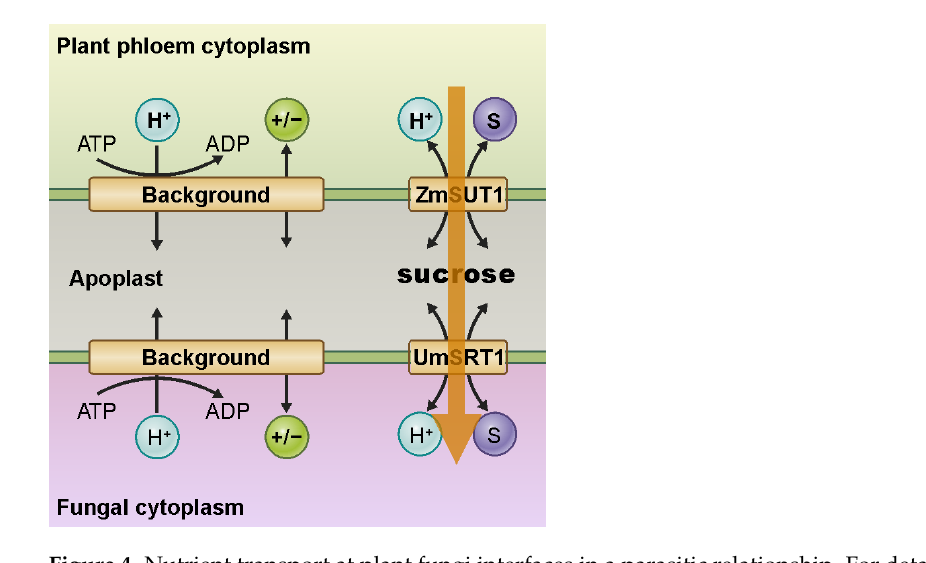
Figure 4. Nutrient transport at plant fungi interfaces in a parasitic relationship. For details, see the text. An animation illustrating more details of this model system can be found in the Supplementary Materials (Animation S3).